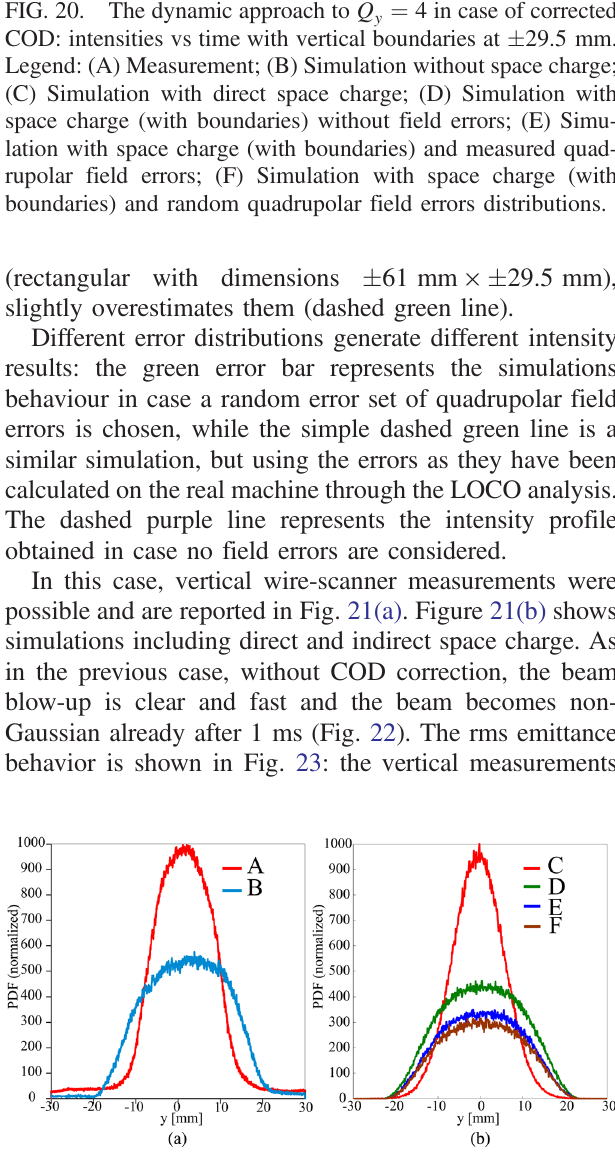
FIG. 21. The vertical profiles in case of COD correction: (a) Measurements, (b) Simulations including the direct space charge and the boundaries. Legend — left: (A) Measurements at 500 ms; (B) Measurements at 560 ms. Legend — right: (C) Simulation: initial vertical profile at 500 ms; (D) Vertical profile at 560 ms (with direct space charge); (E) Vertical profile at 560 ms (SC with vertical boundaries at (cid:2) 40 mm); (F) Vertical profile at 560 ms (SC with vertical boundaries at (cid:2) 29 . 5 mm).